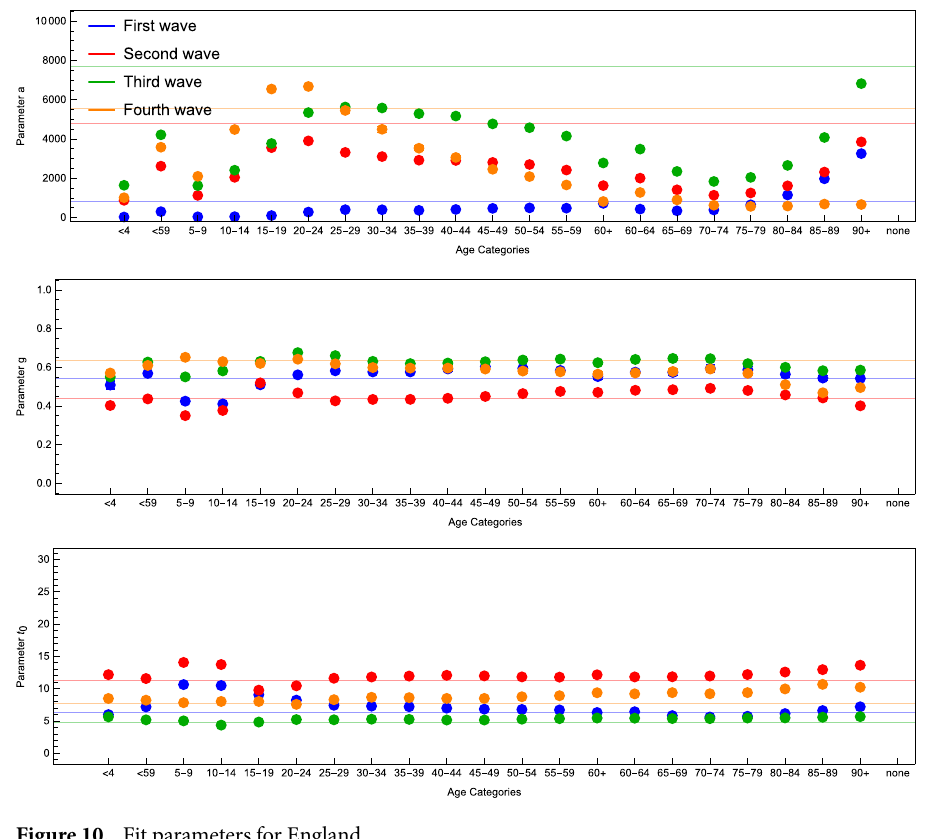
Figure 10. Fit parameters for